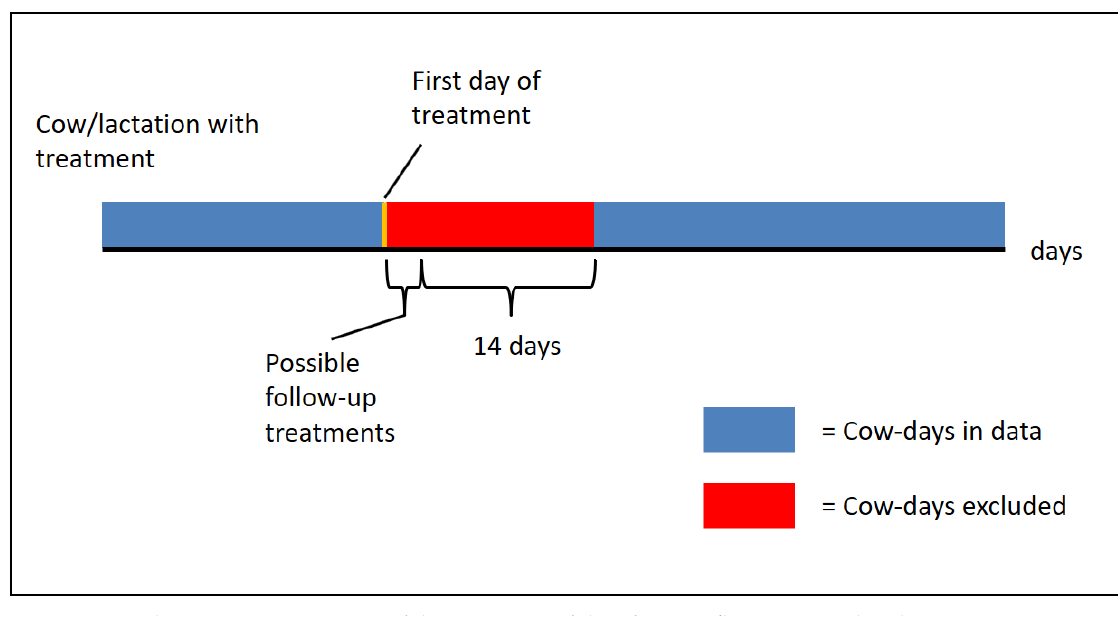
Figure 1. Schematic representation of the extraction of data for cows/lactations with at least one treatment.